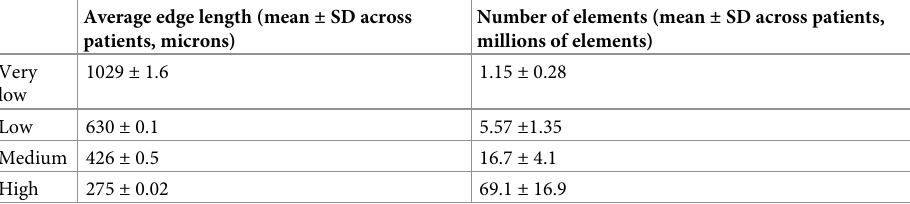
Table 3. Details on meshes used in mesh resolution